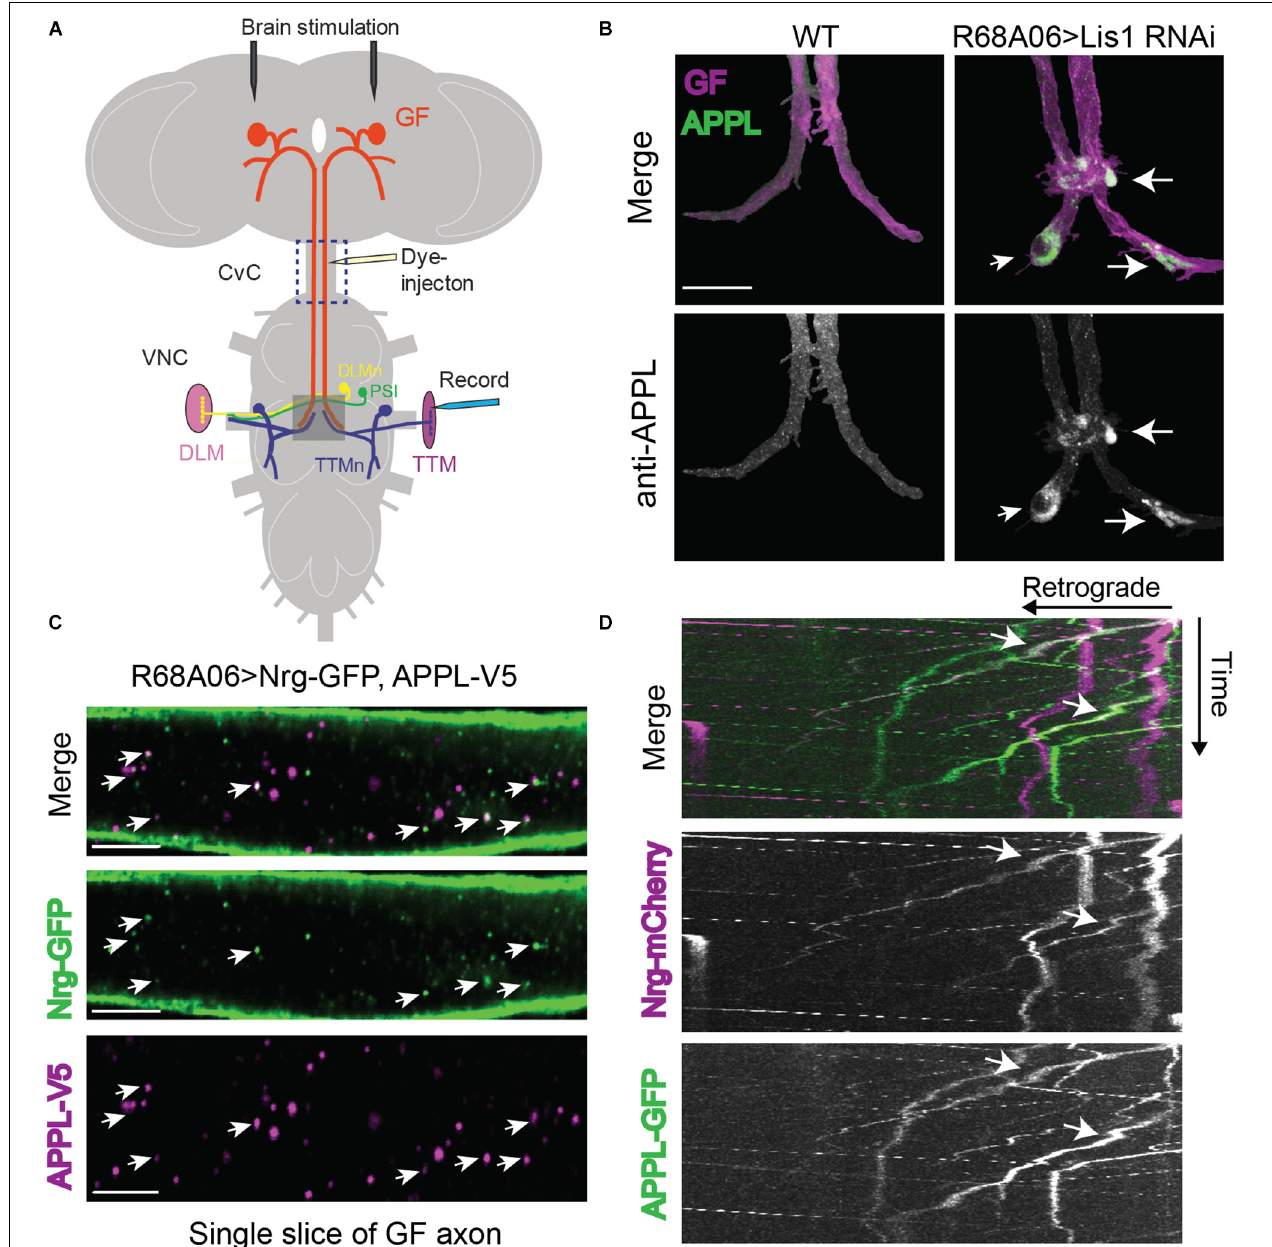
FIGURE 1 | Drosophila Amyloid Precursor Protein (APP) is retrogradely transported and co-traffics with Neuroglian. (A) Diagram of Giant Fiber (GF) circuit in the Drosophila nervous system. The GFs synapse with the TTMn and the peripherally synapsing interneurons (PSI) in the ventral nerve cord (VNC). The circuitry output is via the innervation of the jump (TTM) and flight (DLM, dorsal longitudinal muscle) muscles by the TTMn and DLMn (dorsal longitudinal) motoneurons. Live-imaging of GF axons were performed in the CvC (blue square). Sites of dye injections for GF anatomy visualization and placement of stimulation and recording electrodes for electrophysiological analysis are indicated. Gray box shows area of morphological analysis of GF terminals by confocal microscopy in the ventral nerve cord (VNC). (B) Immunostaining of endogenous APPL (green top panel and white bottom panel) with an antibody against the N-terminal domain in wild type GFs and in GFs in which Lis1 was cell-autonomously knocked down. GFs (magenta, top panel) were labeled by dye injections of rhodamine-dextran into the GF axons. For better visualization, the GFs were digitally traced and 3D-reconstructed to extract anti-APPL labeling that localizes to the reconstructed GFs (bottom panel). APPL accumulation at GF-TTMn and GF-PSI contact sites in Lis1 knock down animals are indicated by arrows. Scale bar represents 30 µ m. (C) Immunolabeling of GFP- tagged Nrg (green) and V5-tagged APPL (magenta) in adult GF axons co-expressed using the R68A06 Gal4-driver. Single confocal slices of the different channels in the same plane are shown separately and together to visualize co-localization (arrows). Scale bar represents 5 µ m. (D) Live-imaging of co-expressed mCherry-tagged Nrg and GFP-tagged APPL in the GF axons ( Supplementary Video S1 ). A small section of the GF axons was photobleached prior to acquisition to reduce background from Nrg labeling at the axonal membrane. Video was obtained at 1 frame per second. Kymographs of APPL-GFP and Nrg-mCherry alone as well as together are shown. Overlapping trajectory of APPL-GFP and Nrg-mCherry vesicles in retrograde direction are indicated by white arrows.